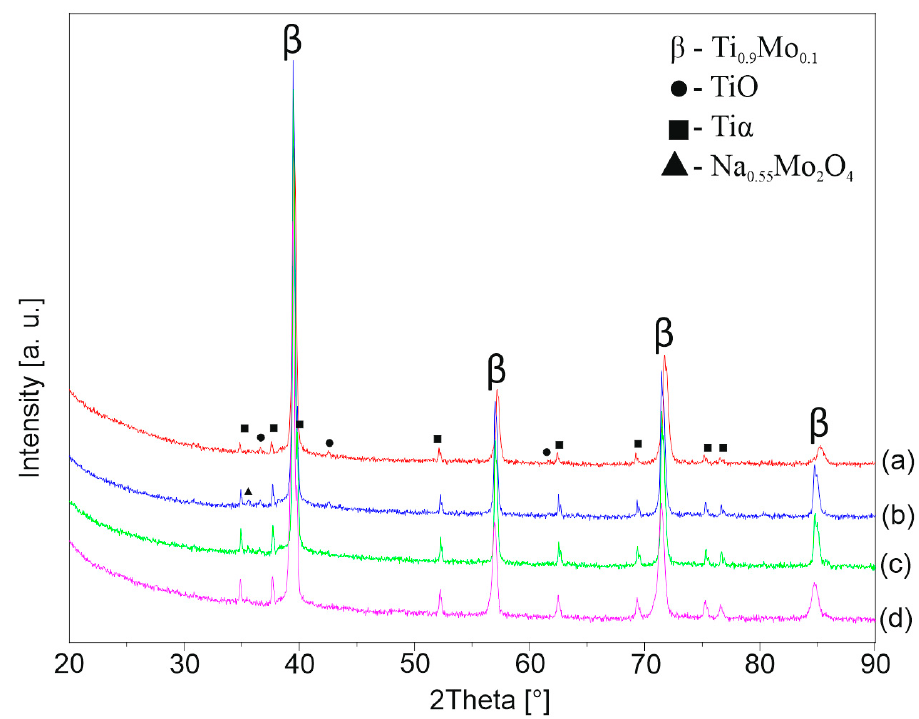
Figure 8. XRD patterns of Ti35Mo after alkaline treatment in ( a ) 5M, ( b ) 7M, ( c ) 10M, ( d ) 12M NaOH solutions.